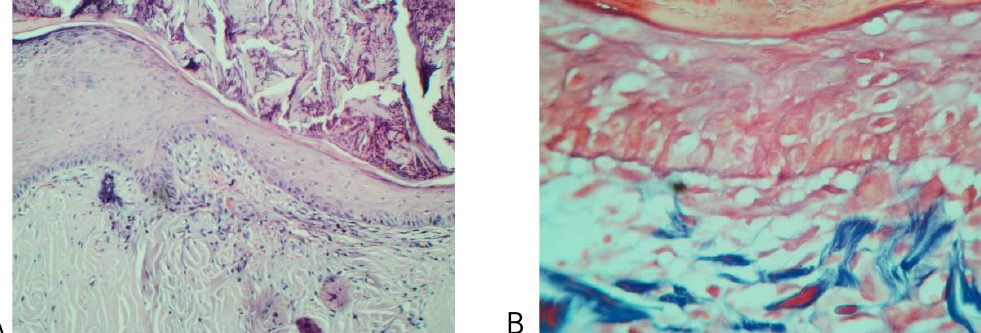
Figure 6: View of Myrrh oil group at day 7 showed, A: keratin , New epithelium, H&E,X10.B: blood vessels, Col: coarse of collagen fibers, G: granulation tissue, MT, X40. Fourteen days duration: Control group: Fig. 7